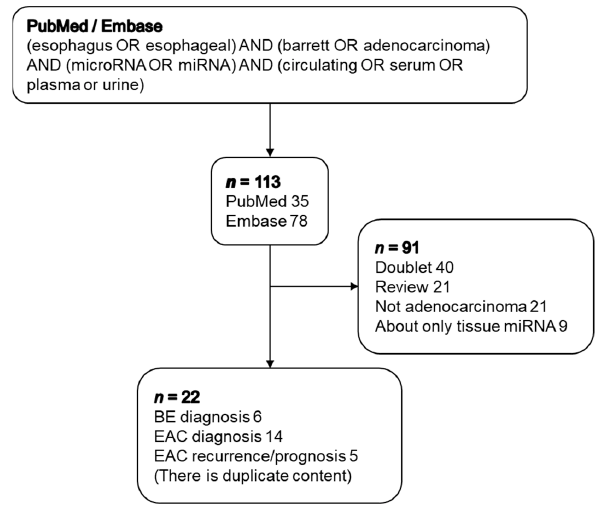
Figure 1. Flow chart showing the selection process.